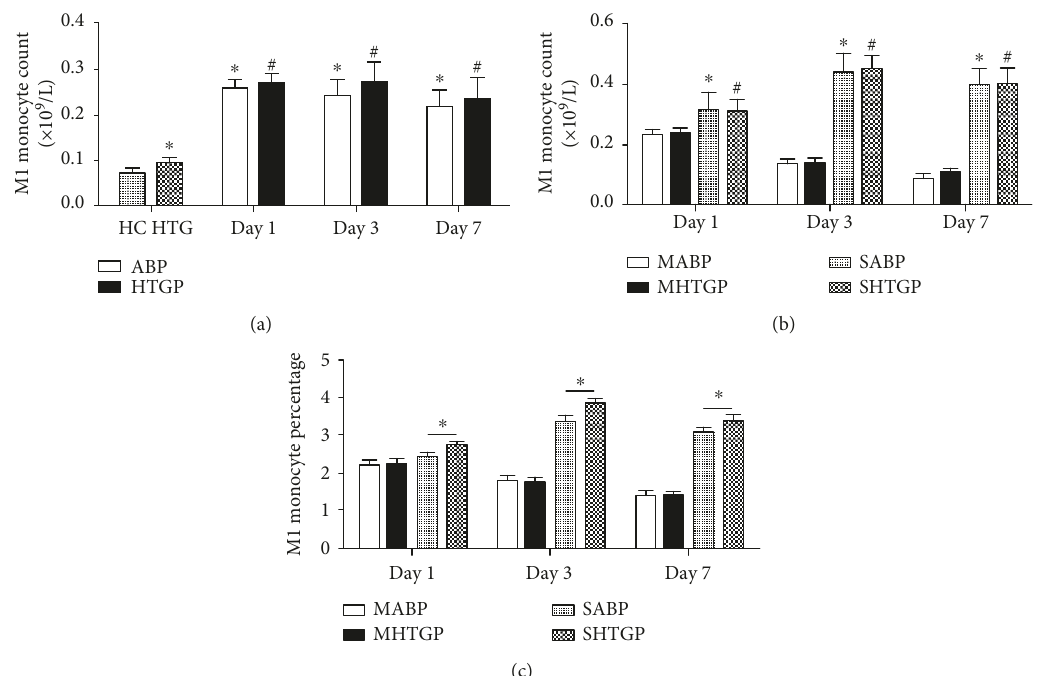
Figure 2: M1 monocyte count and percentage in all subjects on days 1, 3, and 7. ∗ P < 0 05 compared with HC group (a) or MABP group (b). # P < 0 05 compared with HTG group (a) or MHTGP group (b). ∗ P < 0 05 (c).